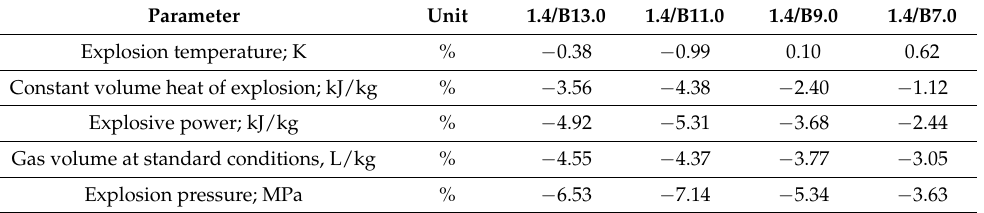
Table 8. Percentage change in the values of individual parameters for EX from variant 1.4 compared to